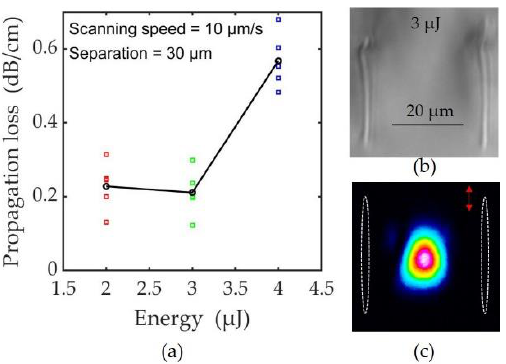
Figure 10. ( a ) Propagation loss versus energy for waveguides written at 10 µ m / s speed and 30 µ m separation. The black curve represents the mean value of propagation loss, whereas the red, green, and blue squares represent the individual propagation loss values at 2 µ J, 3 µ J, and 4 µ J pulse energy values, respectively. ( b ) Transverse cross-section of one of the waveguides written at 3 µ J. ( c ) Guided mode profile corresponding to the waveguide shown in ( b ). The mode field diameter is 15.6 µ m .